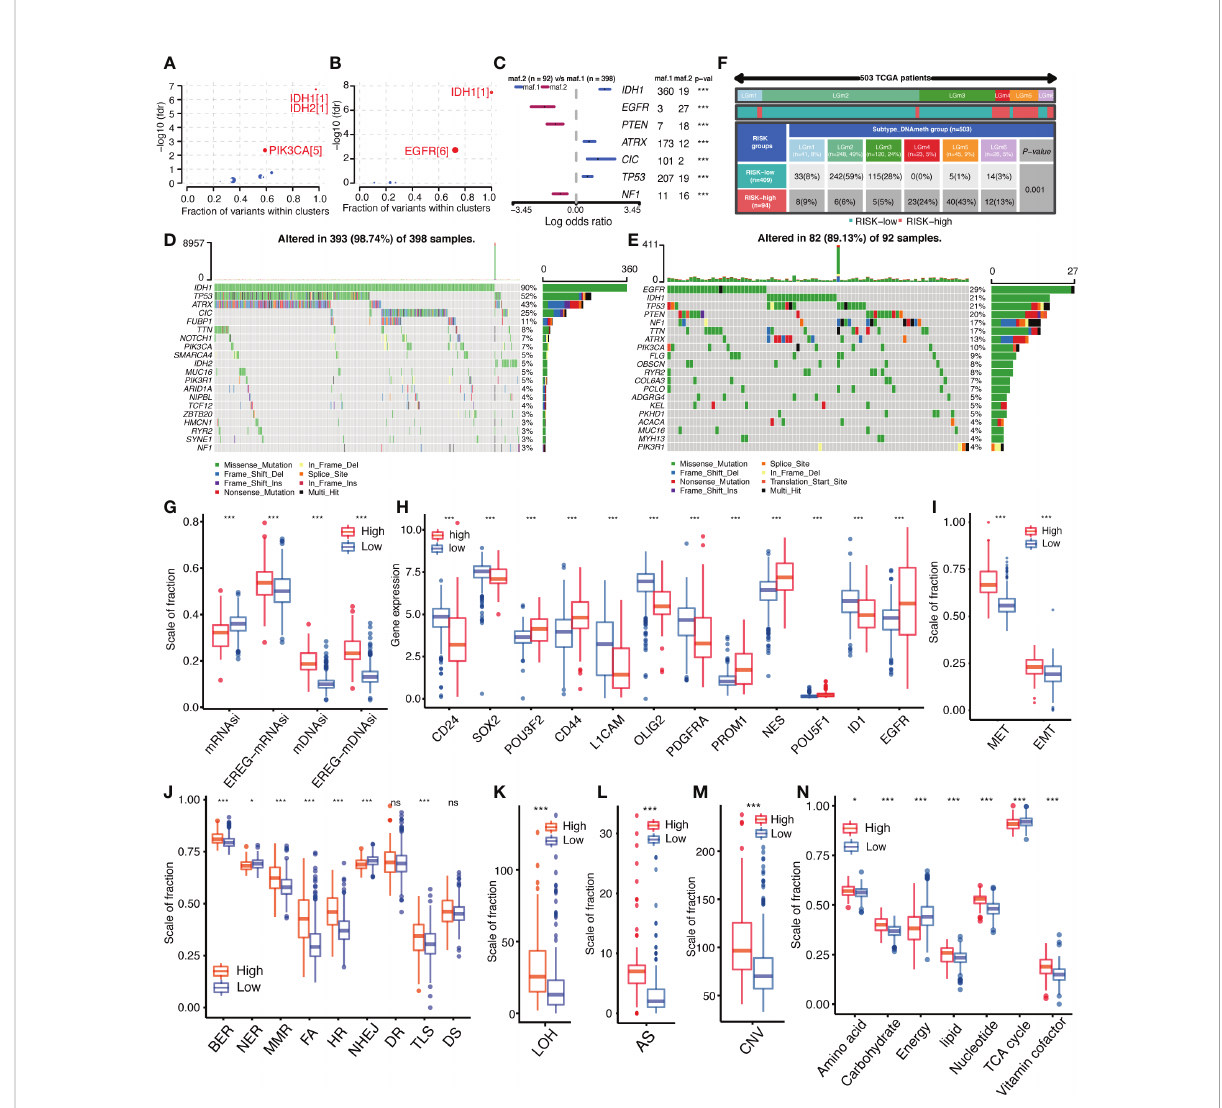
FIGURE 6 Relationship between IGFBPScore and the development of glioma. (A, B) Bubble plot showed the driver genes of High-risk and Low-risk expression groups. (C) Forest plot showed the differential mutation patterns in the High-risk and Low-risk groups. (D, E) Somatic mutation waterfall plots were created based on High-risk and Low-risk groups. (F) Pan-glioma methylation subtypes in High-risk and Low-risk groups. (G – I) Differences in stemness index (G) , markers of glioma stem cells ( H ), and EMT versus MET phenotypes (I) between High-risk and Low-risk groups. (J – M) Differences in DNA damage repair pathways ( J ), LOH ( K ), AS ( L ), and CNV ( M ) between High-risk and Low-risk groups. (N) Differences in the metabolic levels of seven major substances between the High-risk and Low-risk groups. EMT, epithelial – mesenchymal transition; MET, mesenchymal – epithelial transition, BER, base excision repair; MMR, mismatch repair; FA, Fanconi anemia; HR, homology- dependent recombination; NER, nucleotide excision repair; NHEJ, non-homologous end joining; DR, direct repair; TLS, translesion synthesis; DS, damage sensor; LOH, loss of heterozygosity; CNV, copy number variations; AS, aneuploid score; TAC, tricarboxylic acid cycle. For all experiments, mean rank, *p<0.05, ***p<0.001. ns, no signi fi